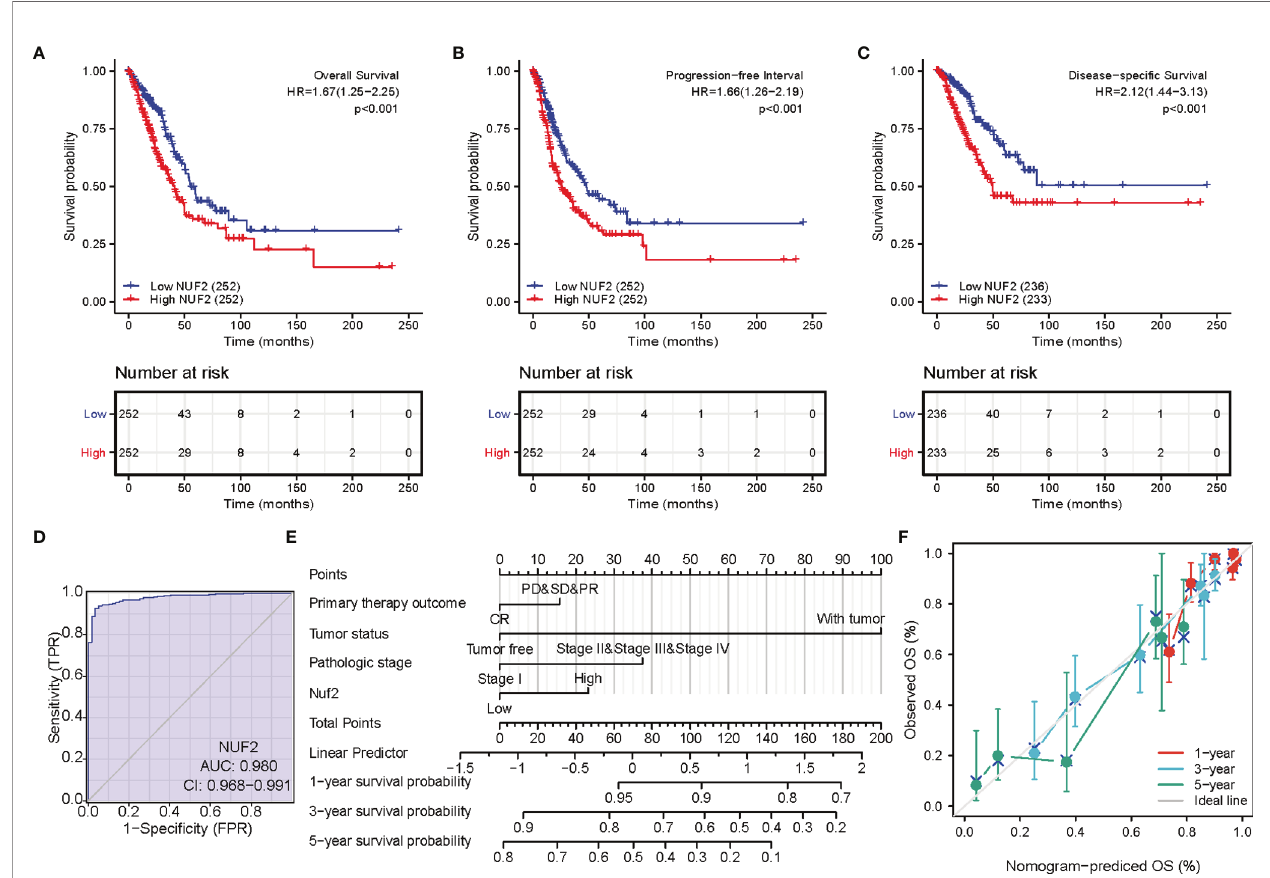
FIGURE 4 | Prognostic value of NUF2 expression in lung adenocarcinoma (LUAD). (A) Survival curves of overall survival. (B) Survival curves of progression-free interval. (C) Survival curves of disease-speci fi c survival. (D) Receiver operating characteristic (ROC) curves of NUF2 in LUAD. (E) Prognostic nomogram that integrated NUF2 expression and other prognostic factors for OS in LUAD from The Cancer Genome Atlas data. (F) A calibration curve at 1-, 3- and 5-year.